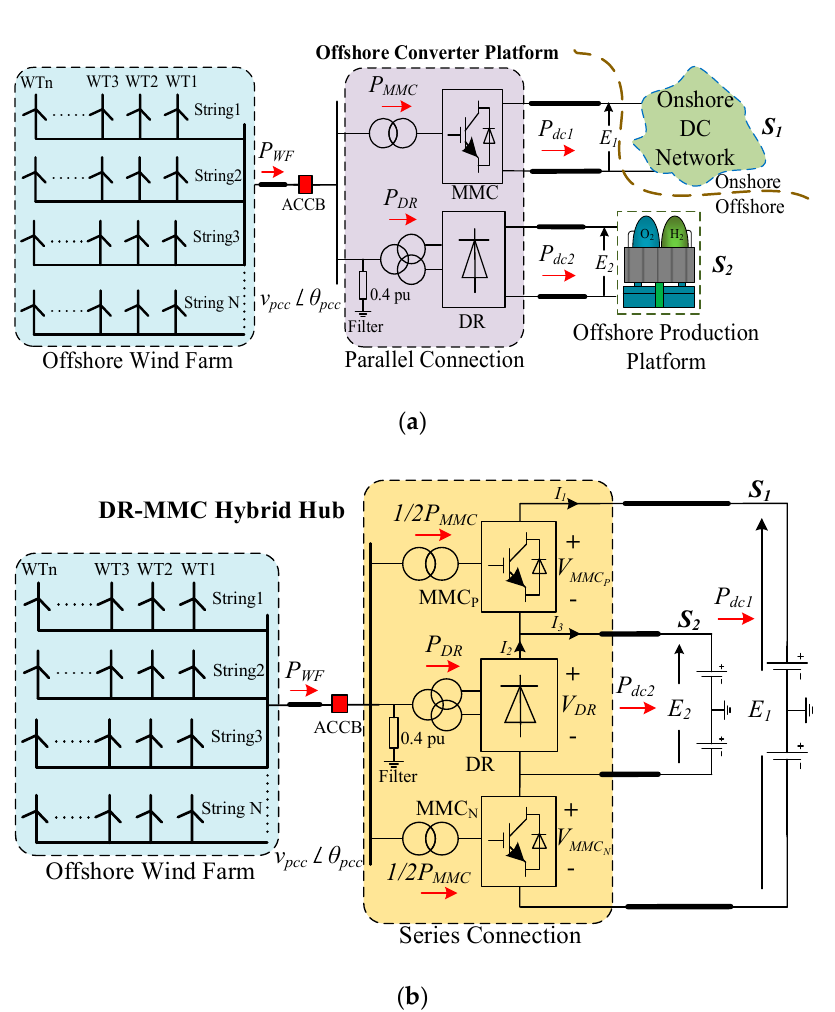
Figure 1. Topologies of the offshore converter station: ( a ) Envisaged scenario for DC network interconnection; ( b ) symmetrical monopole configuration of the proposed DR-MMC Hub.